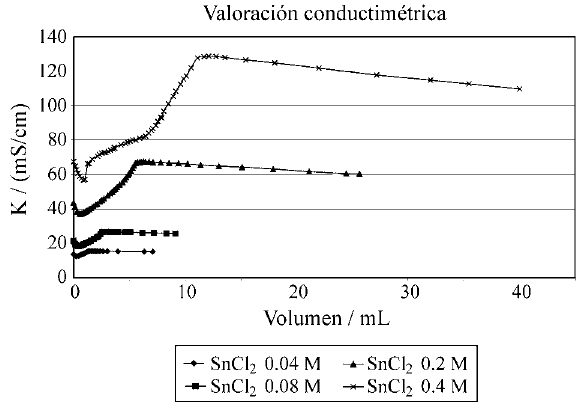
Figura 3a. Curvas conductrimétricas para diferentes concentraciones de SnCl 2 .